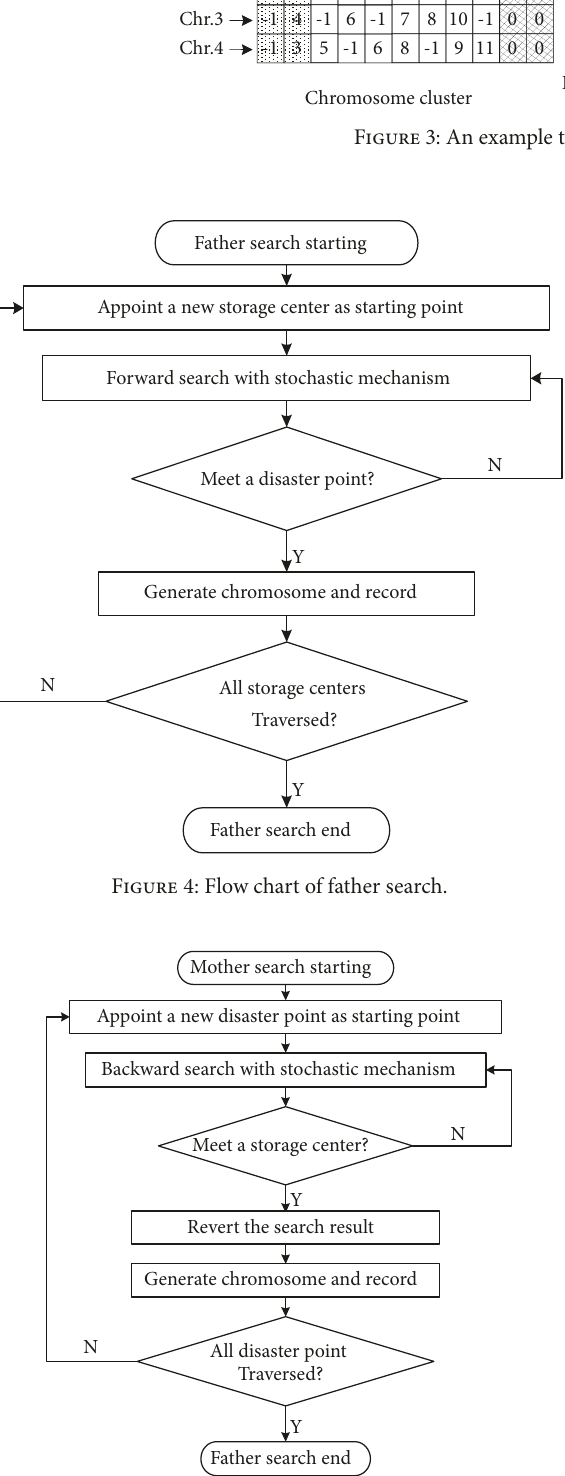
Figure 5: Flow chart of mother